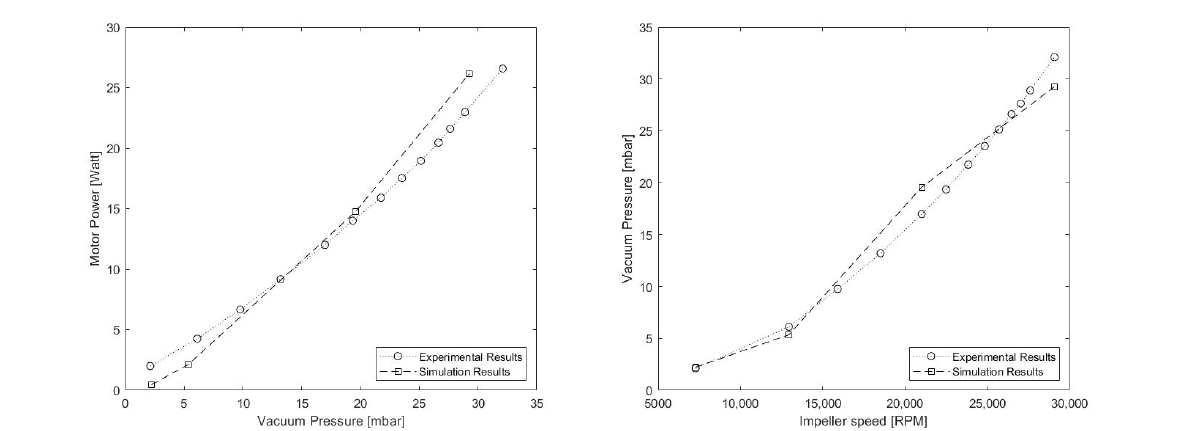
Figure 10. ORP simulation vs. experimental results graph: ( left ) vacuum pressure vs. motor power. ( right ) impeller speed vs. vacuum pressure.